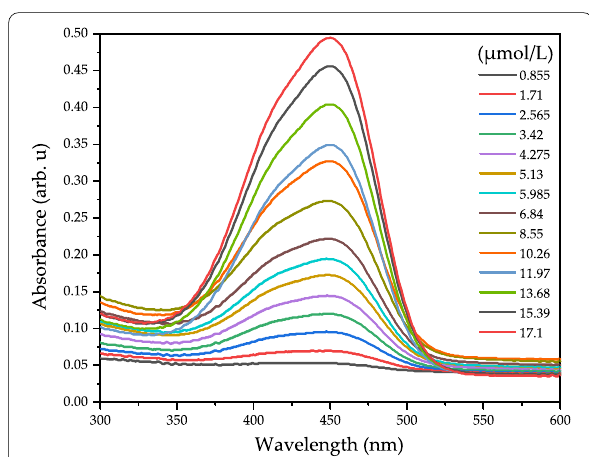
Fig. 5 The linear analysis of direct bilirubin (0.855–17.1 μmol/L) by Hitachi U‑3900 at 460 nm; the regression equation was y 0.0265 x 0.0279, R . 2 of = +